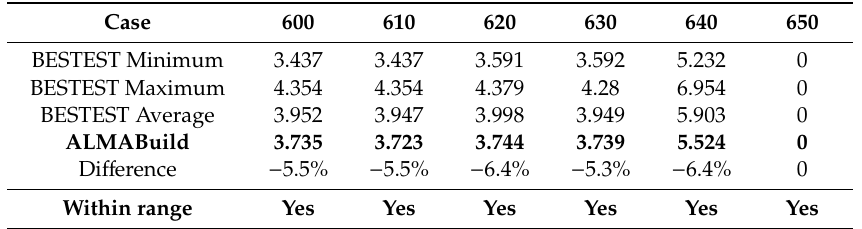
Table 7. Annual Heating Peak (kW) obtained for non-free-float lightweight BESTEST cases compared with the minimum and maximum threshold values indicated by BESTEST.